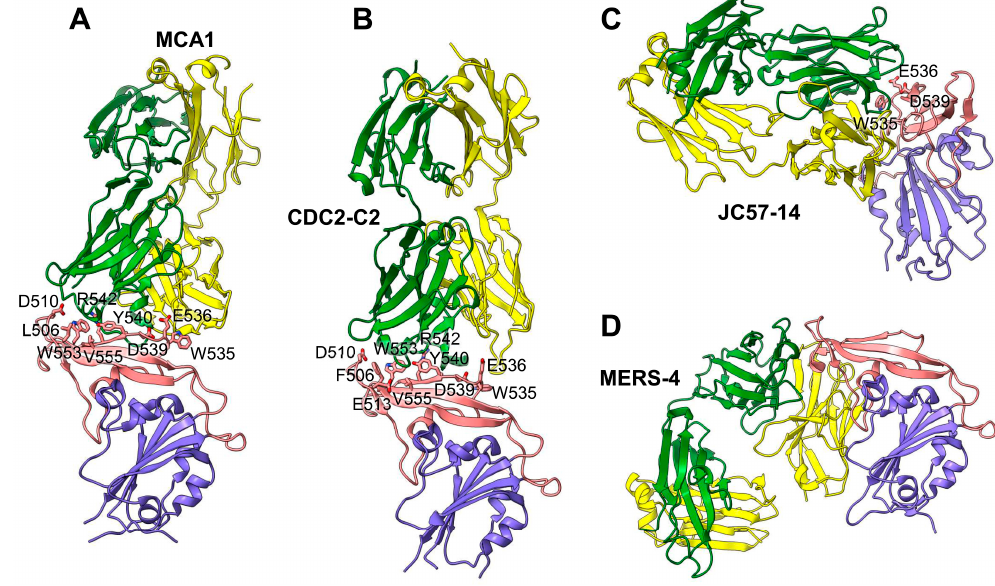
Figure 4. Structural basis for MERS-CoV RBD recognition by neutralizing mAbs. ( A ) Crystal structure of MERS-CoV RBD complexed with MCA1 mAb (PDB ID: 5GMQ). ( B ) Crystal structure of the MERS-CoV RBD complexed with CDC2-C2 mAb (PDB ID: 6C6Z). ( C ) Crystal structure of the MERS-CoV RBD complexed with JC57-14 mAb (PDB ID: 6C6Y). ( D ) Crystal structure of MERS-CoV RBD complexed with MERS-4 mAb (PDB ID: 5ZXV). The MERS-CoV RBD core is colored in blue, the RBM is colored in red, and the heavy chains and light chains of each mAb are colored in green and yellow, respectively. The DPP4-binding residues that are blocked by each mAb are shown as sticks. mAb, monoclonal antibody; MERS-CoV, Middle East respiratory syndrome coronavirus; PDB, protein data bank; RBD, receptor-binding domain; RBM, receptor-binding motif.